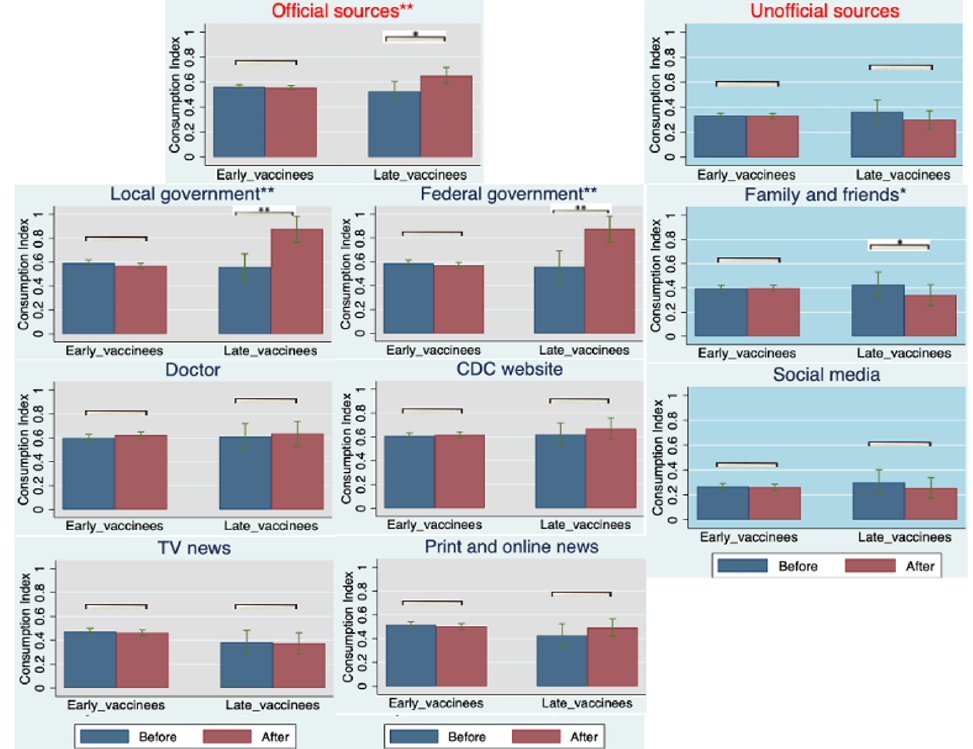
Figure 3. For all early and late vaccinees who received their booster shots, the graphs depict the mean values of consumption indexes before and after the booster shots. For each group, separate t -tests were performed, and p -values are reported at the top of each group being compared (gray shadow: official sources; blue shadow: unofficial sources). The star levels on the titles are the comparison between early and late vaccinees on the difference before and after the booster shots. (Statistical significance at * p < 0.05 and ** p < 0.01 are